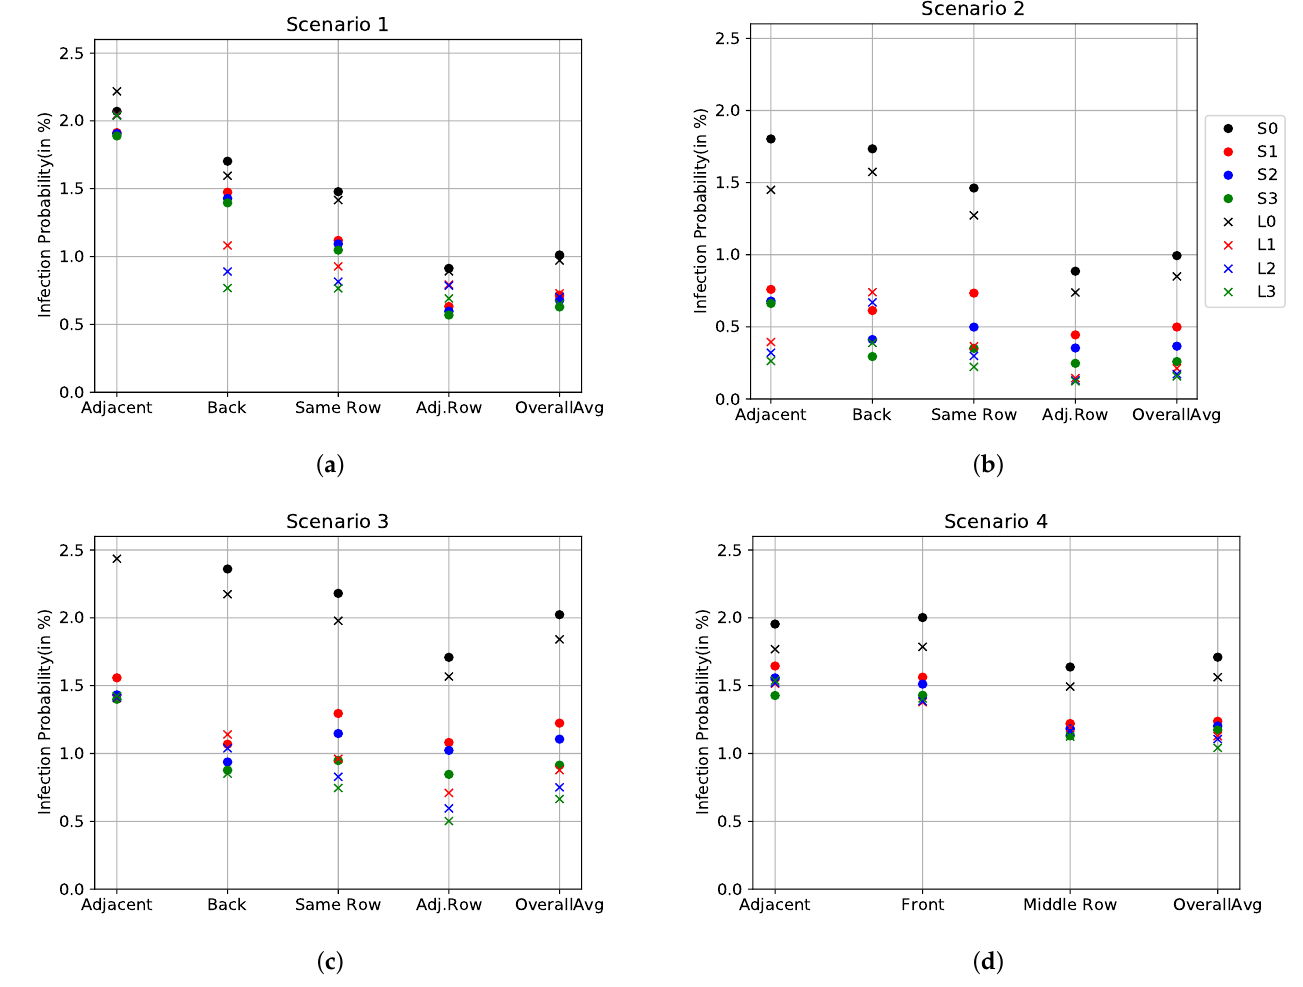
Figure 6. Effect of using AP for ( a ) Scenario 1, ( b ) Scenario 2, ( c ) Scenario 3, ( d ) Scenario 4. The keys in the legend with prefix ’S’ and ’L’ refer to the AP placed on the short side and long side of the room, respectively. The numerical suffix refers to the volumetric flow rate level of the